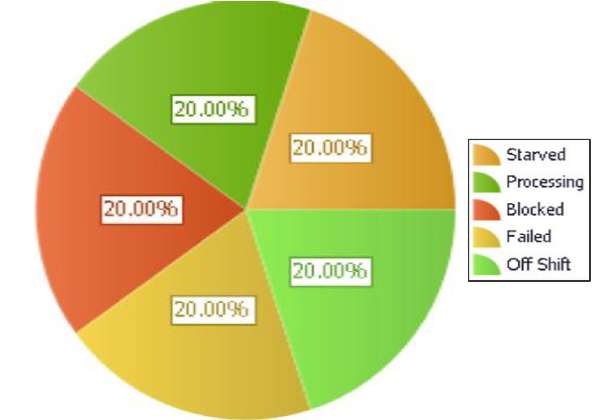
FIG. 5. STATUS PIE CHART OF COMPLETE SIMULATION